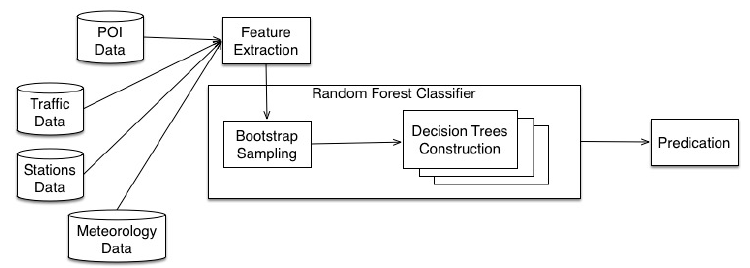
Figure 6. The procedure of RAQ.